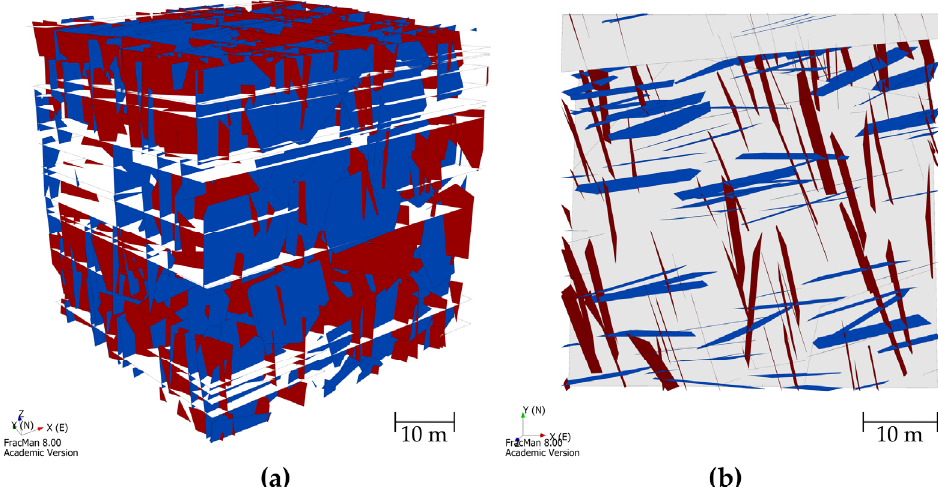
Figure 3. ( a ) Location of the Remlingen quarry in southern Germany; ( b ) Part of the Remlingen sandstone quarry used for the geometrical fracture network analysis and rock mechanical testing; ( c ) Stereonet (lower hemisphere plot) showing the fracture network orientation of the Remlingen sandstone [50]. Table 1. Geometrical properties of the fracture sets from the Remlingen quarry (R1–3) [50]. P 10 and P 32 represent the number of fractures per unit length and the area of fractures per unit volume, respectively.